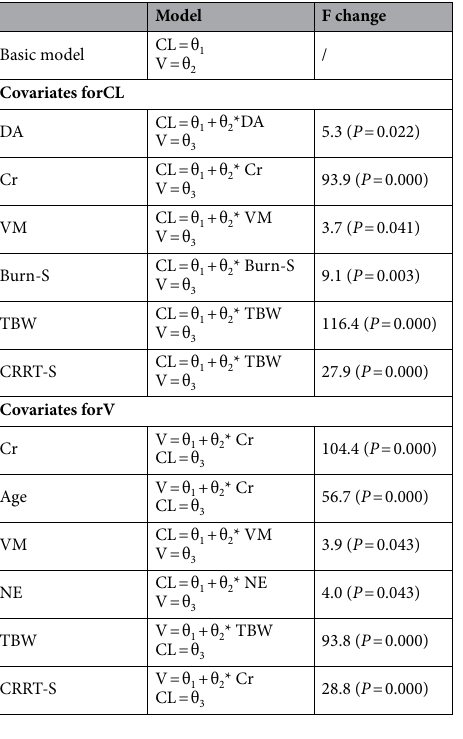
Table 2. Intermediate models showing the influence of the different covariates on the vancomycin pharmacokinetic parameters. Increases in the F value (F-change) represent the degree of influence of the addition of the corresponding covariate on CL and V ( P < 0.05 represent that addition of the corresponding covariate to the base model has a significant effect on CL and V). DA dopamine; Cr serum creatinine; VM vancomycin manufacturer; Burn-S burn status; TBW total body weight; CRRT-S continuous renal replacement therapy status; NE noradrenaline.